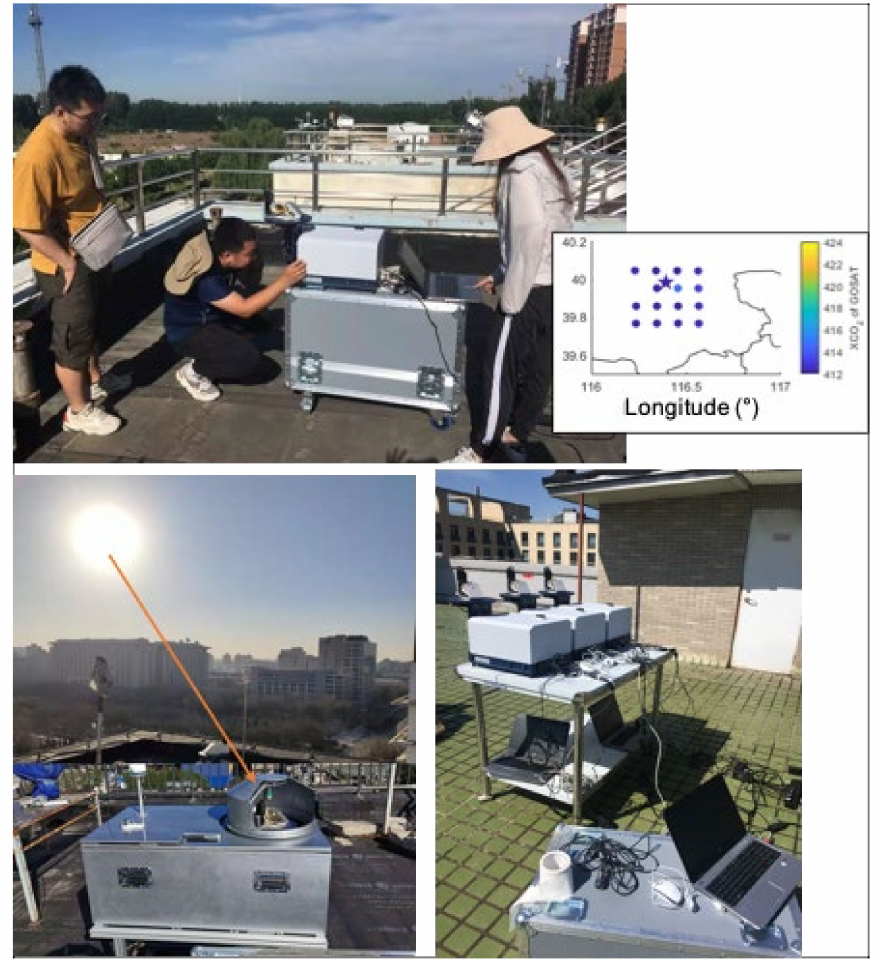
Figure 8. EM27/Sun observations in Beijing. Top right, calibration of the EM27/SUN with 125HR in Xianghe, Hebei. Bottom left: Portable automated enclosure for EM27/SUN. Bottom right: Cross vali- dation of multiple EM27/SUN at Institute of Atmospheric Physics (IAP) at urban Beijing. Top right: Comparison of GOSAT and EM27 XCO 2 observation. EM27 site is indicated by